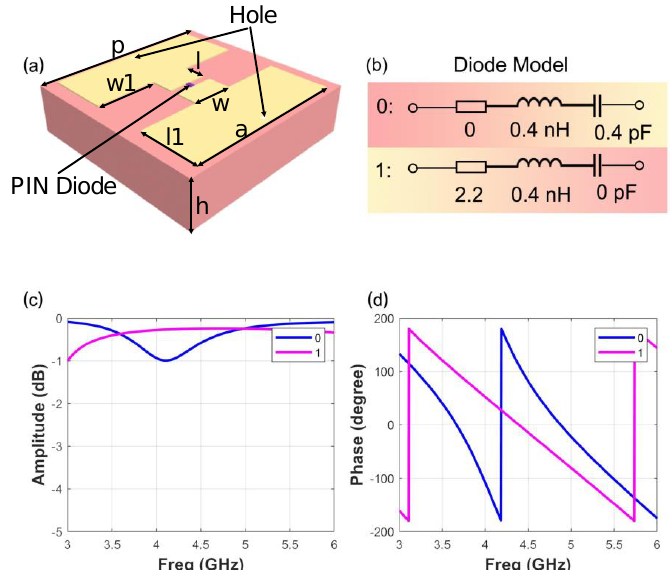
Figure 2. Description of the structure and EM response of meta-atom. ( a ) Three-dimensional perspective view of the supercell. ( b ) Equivalent circuit of PIN diode in OFF/ON state. ( c ) Magnitude-response of the element. ( d ) Phase-response of the element.